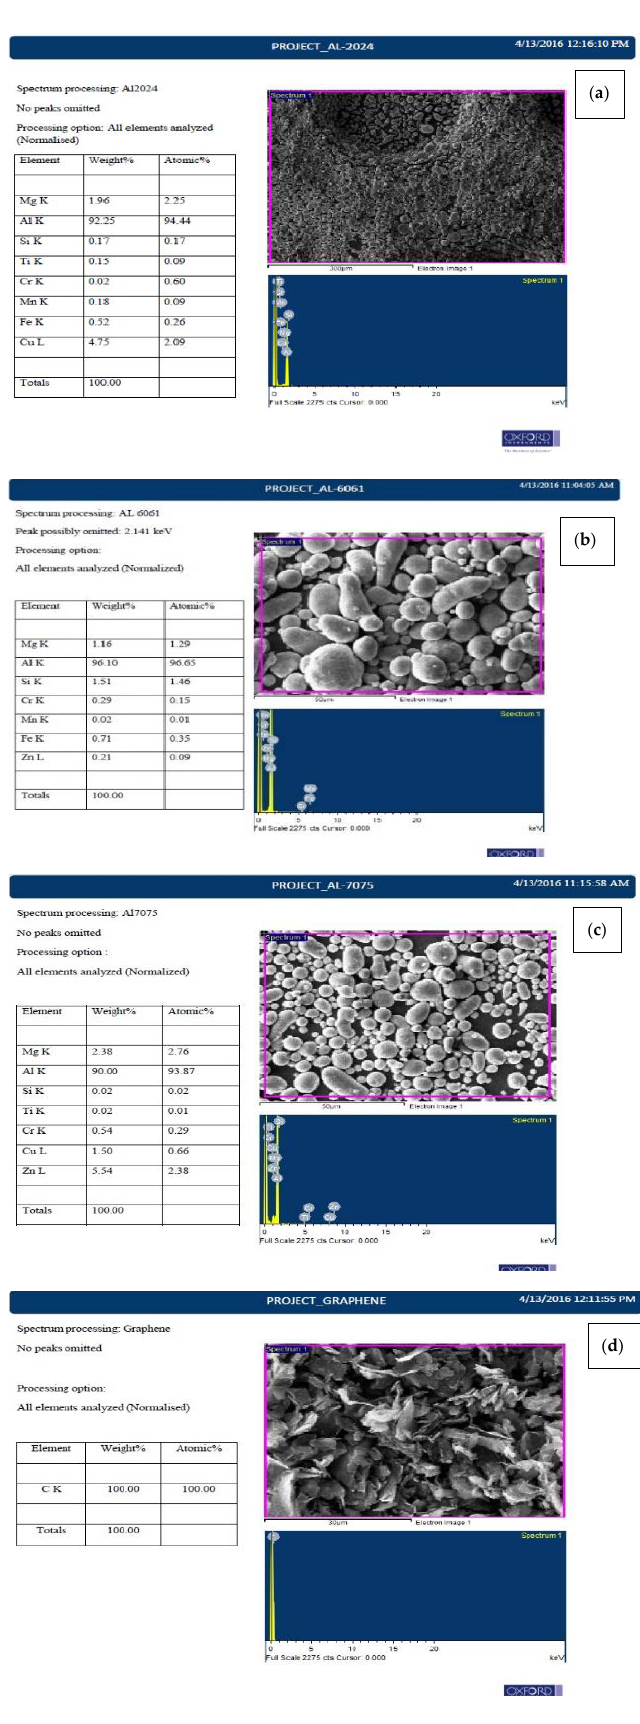
Figure 9. FESEM pictures of received ( a ) AA 2024, ( b ) AA 6061, ( c ) AA 7075 and ( d ) Graphene.